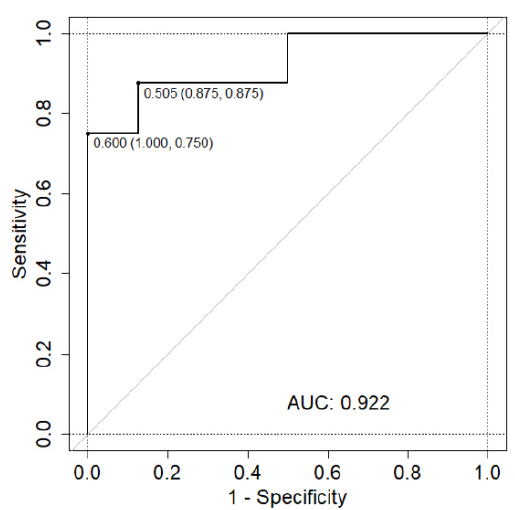
Figure 6. Machine learning on the proteomics data generated a model capable of predicting melanoma metastasis. Significantly differentially expressed proteins were trained on 67% of the data (32 melanoma samples) using 5-fold cross validation repeated 3 times. Missing values were median imputed. Several different algorithms were tested for performance by ROC analysis and then the best performing tested on the 33% of data held out for testing (16 melanoma samples).